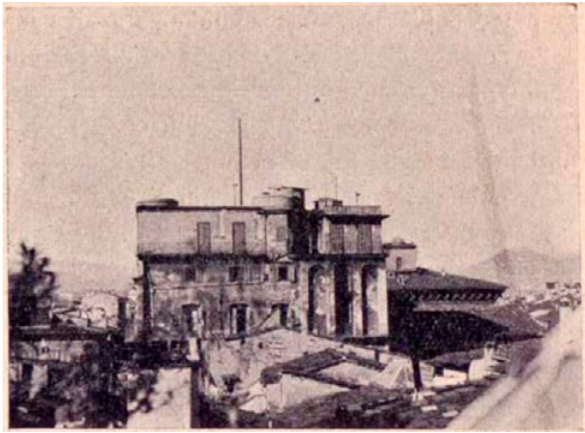
Figure 1. The Ximeniano Observatory seen from South and show- ing the antenna of the radiotelegraphy station. 3